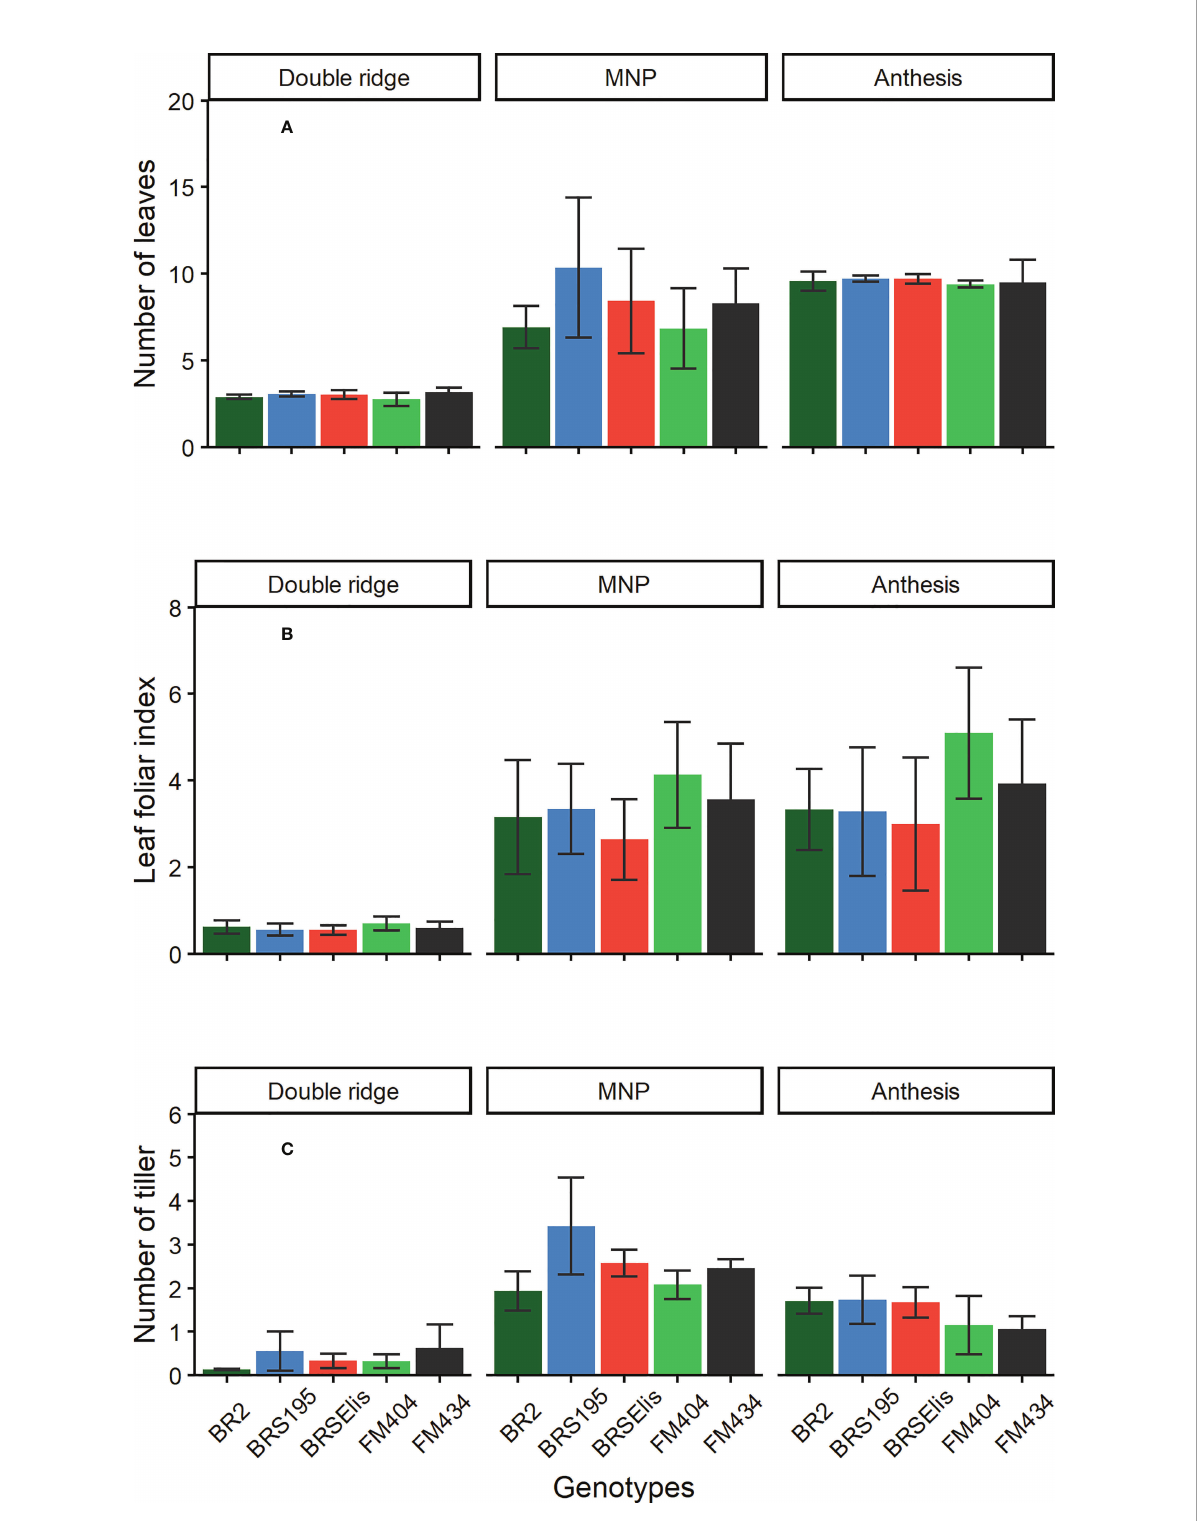
FIGURE 2 Number of leaves (A) , leaf foliar index (B) and number of tillers (C) in the main stem in different development stages of barley cultivars. MNP, Maximum number of spikelet primordia. Bars stand for the standard error (SE) of the